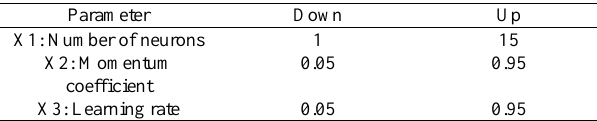
Table1. The range of artificial neural networks parameters